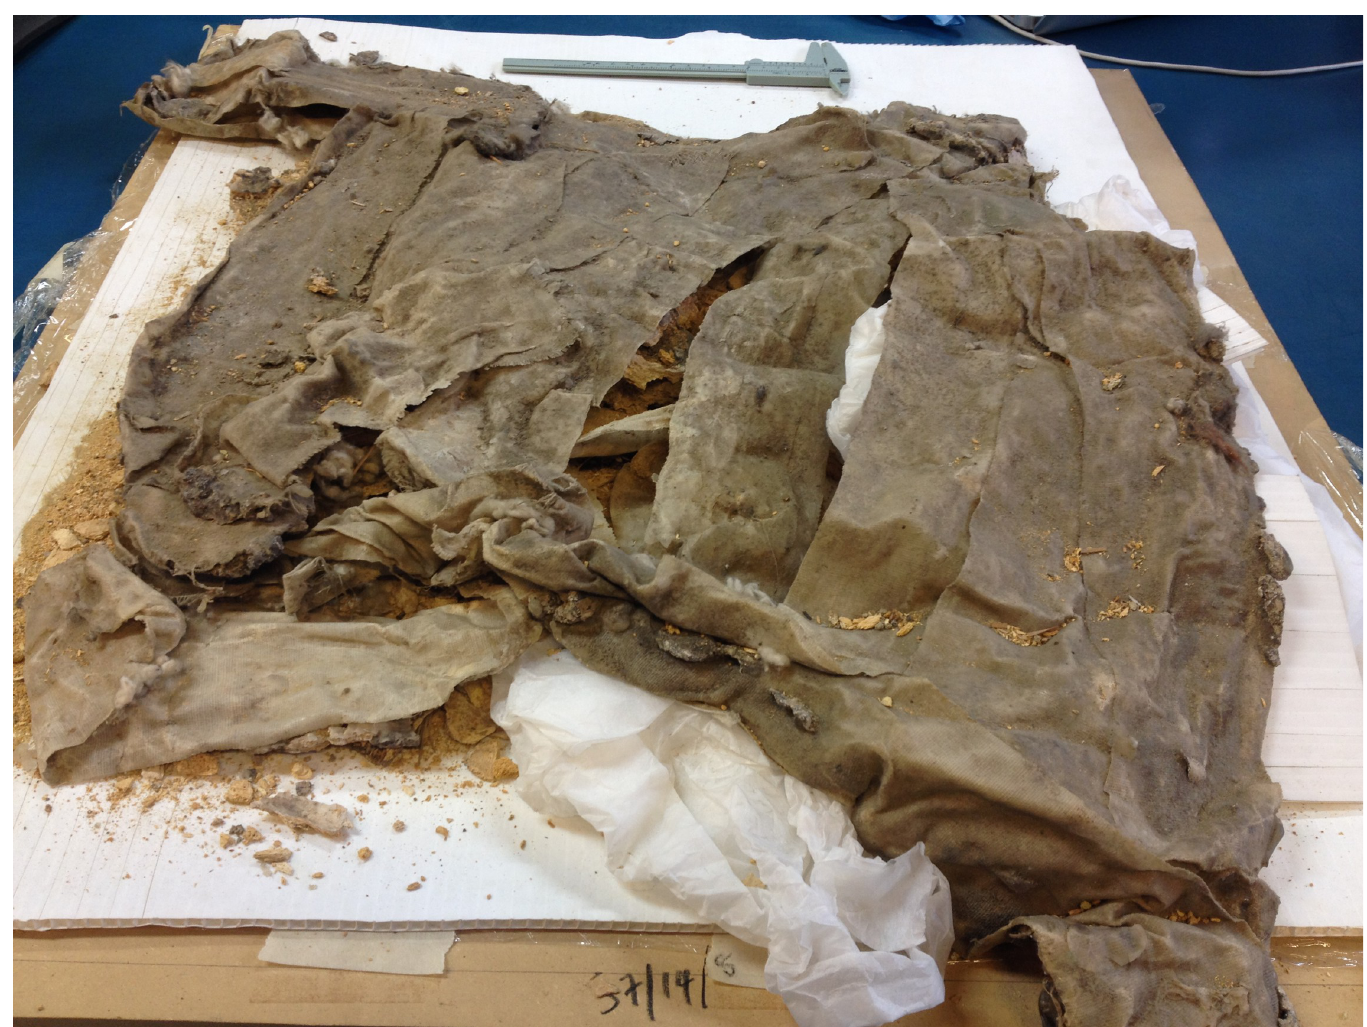
Fig 4. Cattle specimen BM1 (1935.01.16,16) “tooth 6” from PG789 “The Kings Grave” (Greenfield